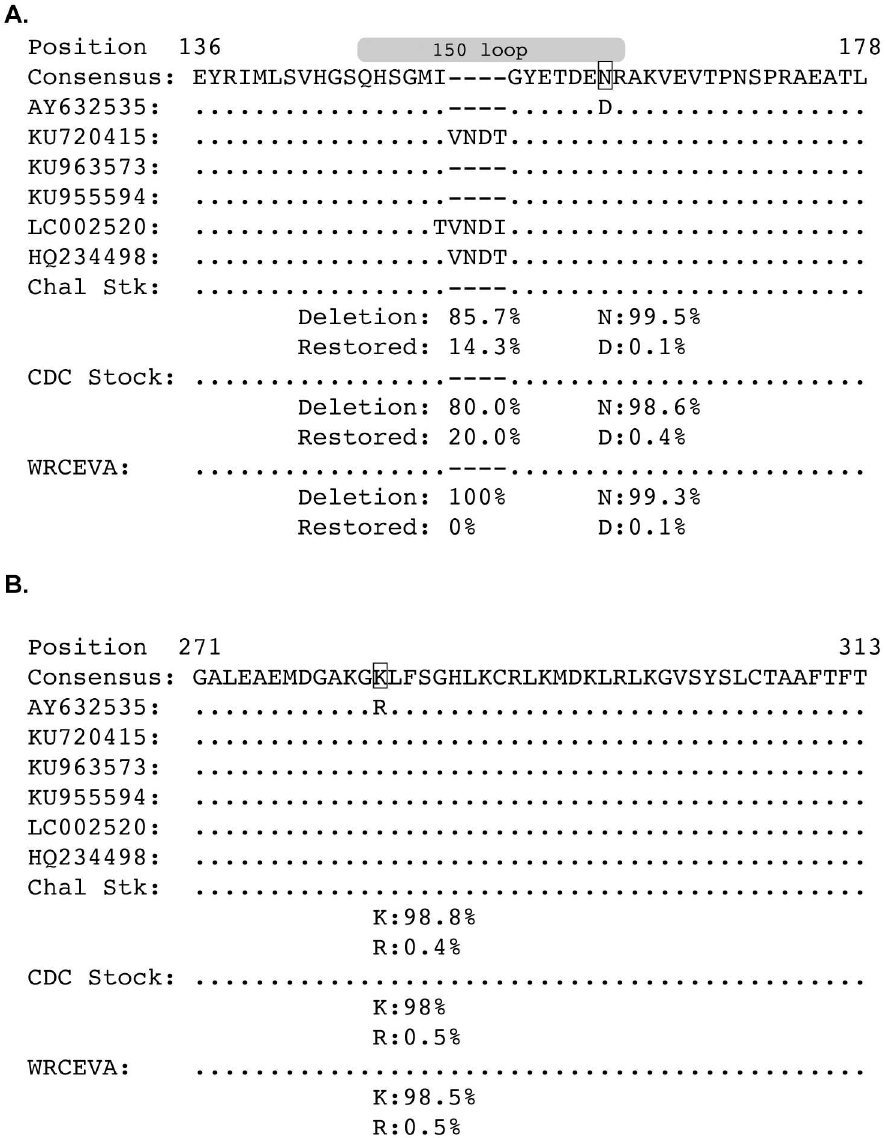
Fig 1. East African ZIKV MR766 envelope sequences often contain an in-frame deletion of an N-linked glycosylation site and are heterologous with respect to Asian ZIKV. The amino acid sequencesof the Envelope protein for six ZIKV MR766 Genbank sequenceswere alignedto the consensus amino acid sequencesof the three ZIKV MR766 stock viruses (Chal Stck, CDC Stock, and WRCEVA stock) using a Muscle alignment in Geneious. Dots represent identity to the consensussequence.Dashes represent deletions. Only sections of the E protein with variations are shown, all other parts of the E protein showedno variation. Capital letters represent amino acids. The frequenciesof the deletionand the restored deletionare shown beloweach of the stock sequences.Genbank reference sequenceAY632535had two amino acids that were different from the other reference sequences. The frequency of reads with these amino acid variants as determinedby deep sequencing are shown below each of the stock sequences. A. Envelope protein amino acid region 136–178. The gray ellipseabove the sequencesrepresent the 150 loop of the E protein [20]. B. Envelope protein amino acid region